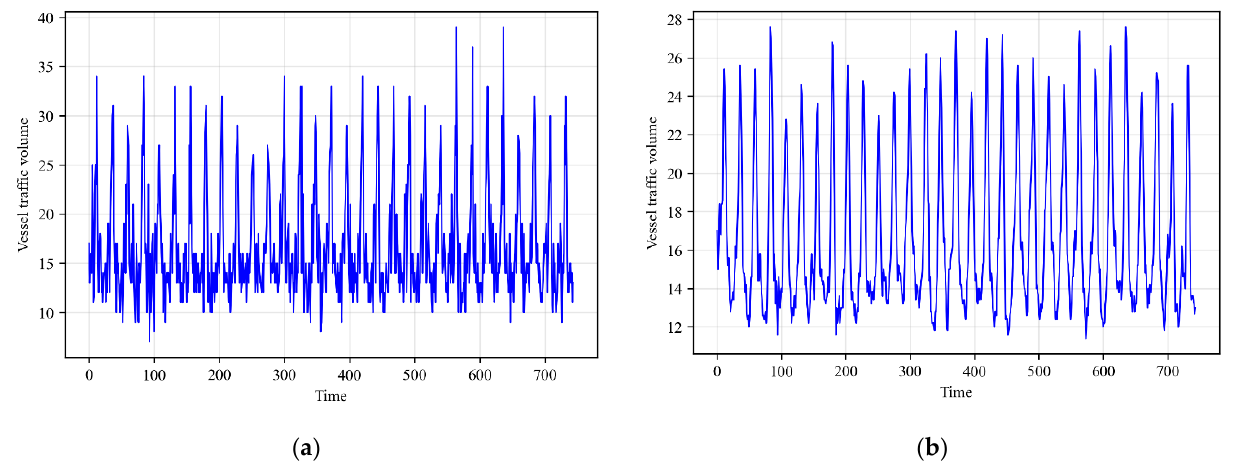
Figure 5. Comparison of the data before and after processing: ( a ) original data; ( b ) processed data.